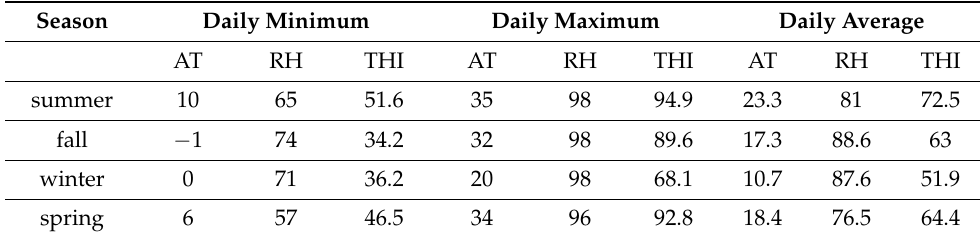
Table 4. Average daily minimum and maximum ambient temperature in degrees Celsius (AT), relative humidity as a percentage (RH), and records of the temperature humidity index (THI) during the study